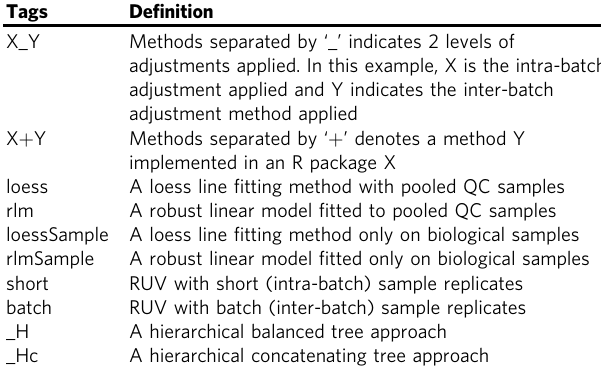
Table 2 A normalisation method abbreviation